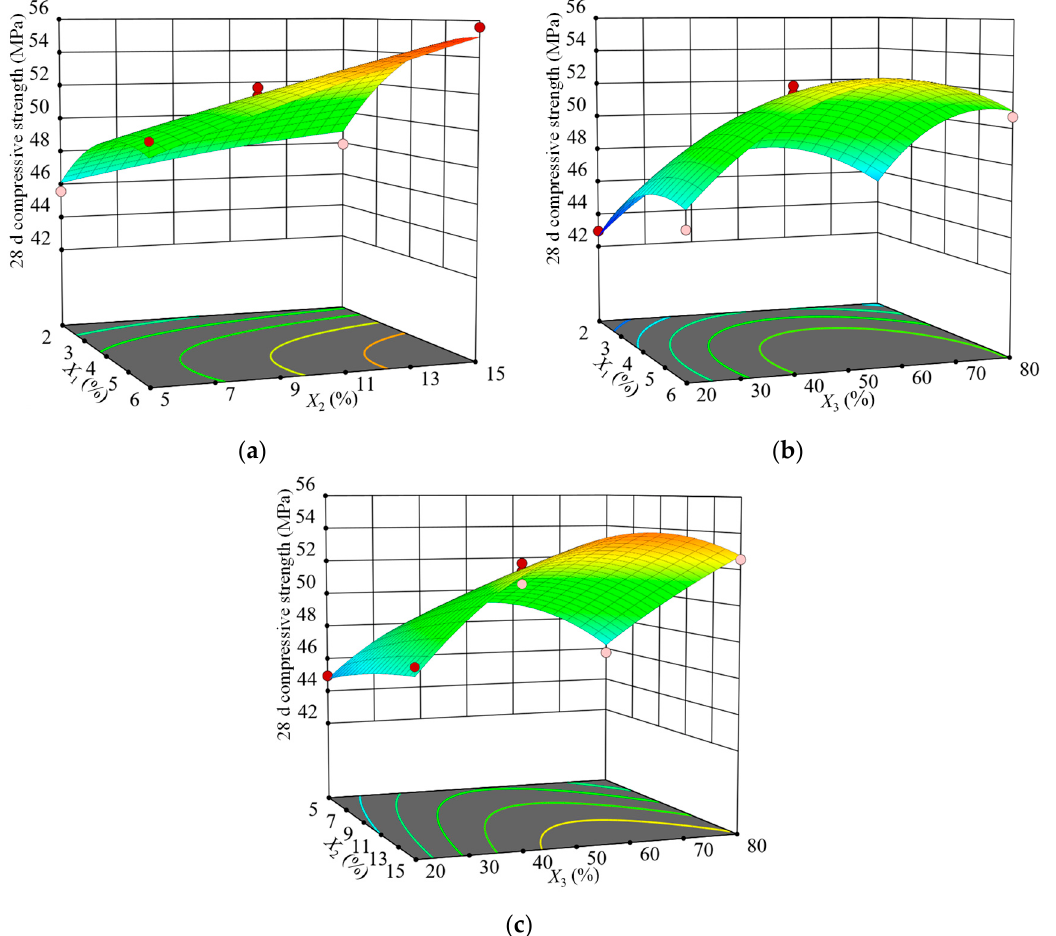
Figure 4. Influences of the interactions of various factors on the 28 d compressive strength: ( a ) X 1 and X 2 , ( b ) X 1 and X 3 , and ( c ) X 2 and X 3 .